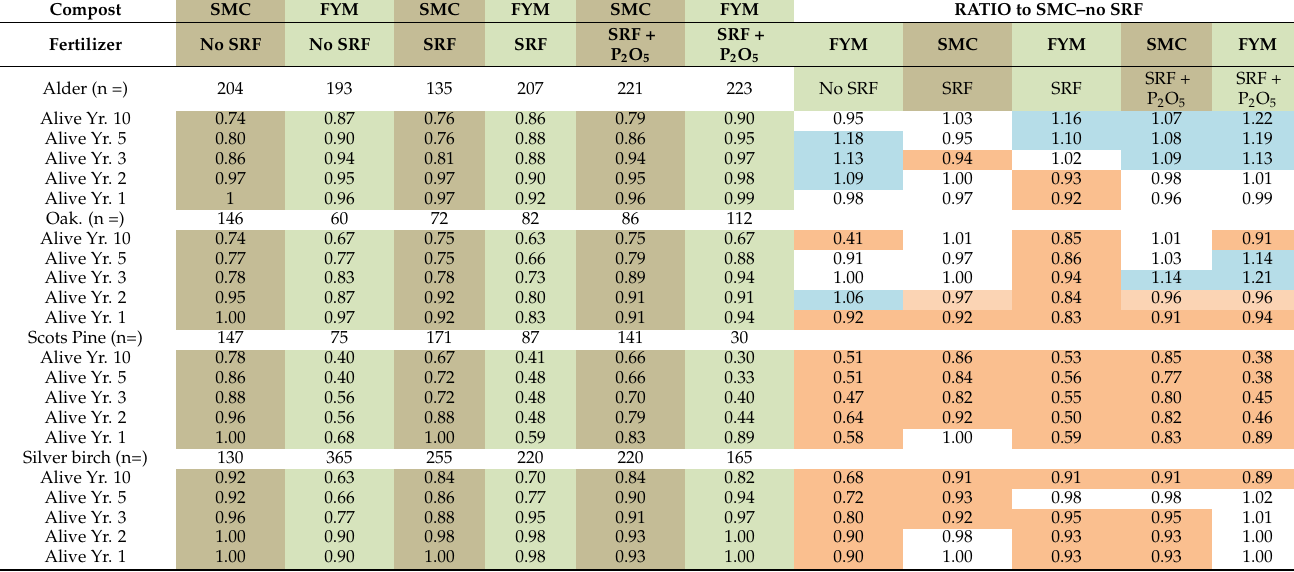
Table 6. Survival by species, compost and fertilizer supplement (blue shading indicates <5% benefit from fertilizer strategy, amber >5% disbenefit).